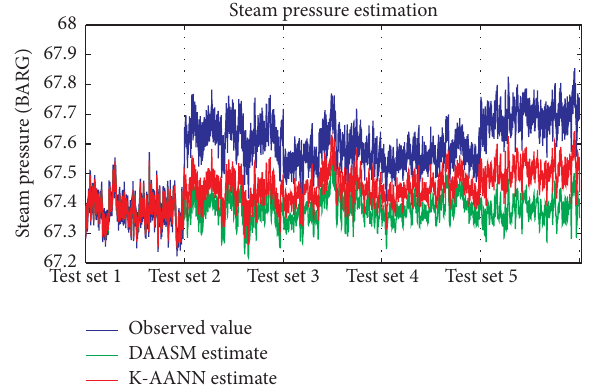
Figure 17: Steam pressure estimates against offset failures up to 0.3 (BARG).